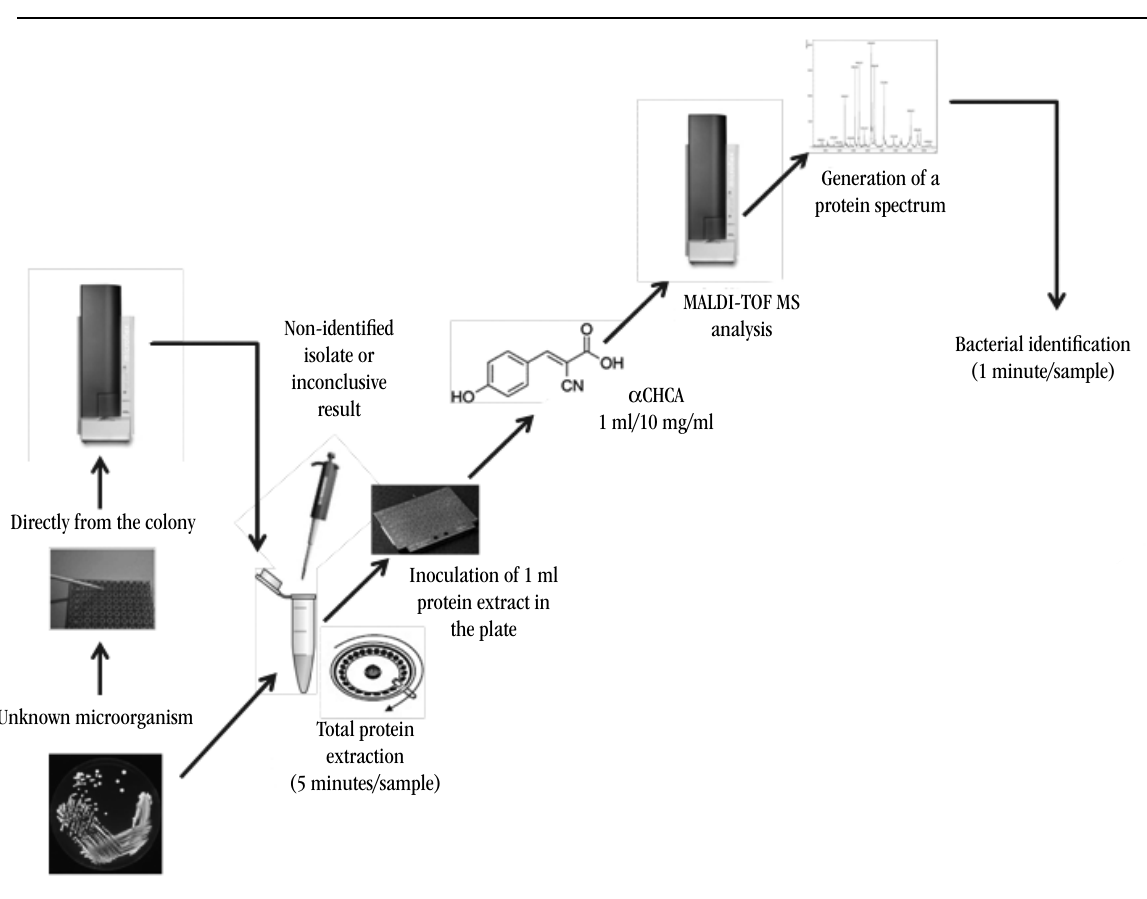
Directly from the